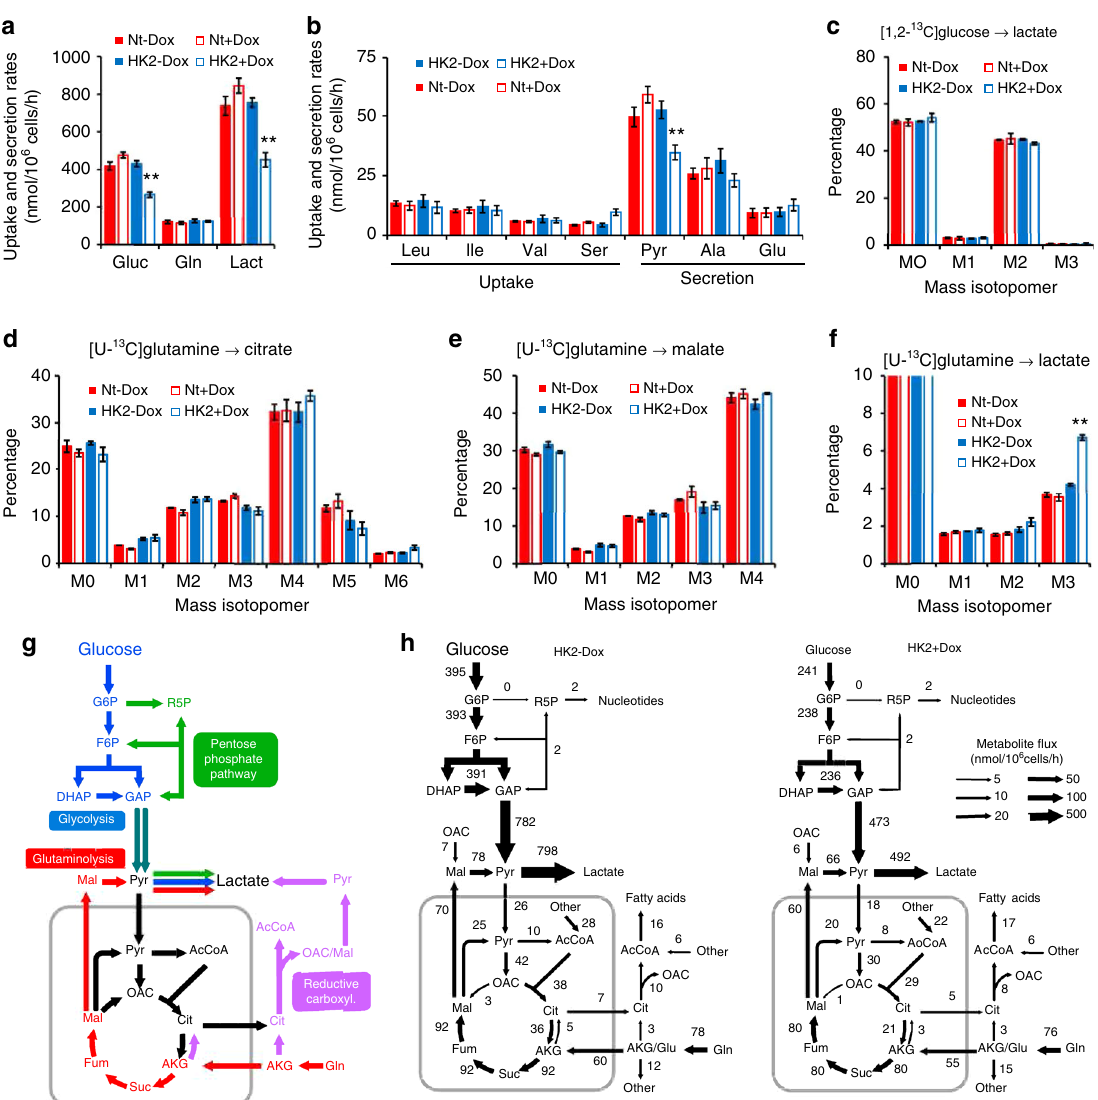
Fig. 4 HK2 knockdown in Huh7 cells reduces glycolysis fl ux to lactate. a Glucose and glutamine uptake rates and lactate secretion rate in Huh7 cells expressing HK2-targeting shRNA (HK2), or non-targeting shRNA (Nt), under induced conditions (+Dox) or non-induced conditions ( − Dox) ( n = 8, biological replicates). b Uptake and secretion rates of pyruvate and amino acids ( n = 8, biological replicates). c Mass isotopomer analysis of extracellular lactate in cultures with [1,2- 13 C]glucose and unlabeled glutamine ( n = 2, biological replicates). d Mass isotopomer analysis of citrate in cells cultured with [U- 13 C]glutamine and unlabeled glucose ( n = 2, biological replicates). e Mass isotopomer analysis of malate in cells cultured with [U- 13 C]glutamine and unlabeled glucose ( n = 2, biological replicates). f Mass isotopomer analysis of extracellular lactate in cultures with [U- 13 C]glutamine and unlabeled glucose ( n = 2, biological replicates). g Predominant metabolic pathways of glucose and glutamine metabolism in mammalian cells. h Metabolic fl ux distributions in Huh7 cells (HK2 - Dox) and Huh7 cells with HK2 knockdown (HK2 + Dox). Fluxes were determined by integrating uptake and secretion rates and isotopic labeling data from [1,2- 13 C]glucose and [U- 13 C]glutamine tracer experiments by metabolic fl ux analysis. Arrow widths indicate absolute magnitudes of net fl uxes (nmol/10 6 cells/h). Complete mass isotopomer distributions are shown in the Supplementary Data. All data represent the mean ± SD, ** p < 0.001 by Welch ’ s unequal variances t